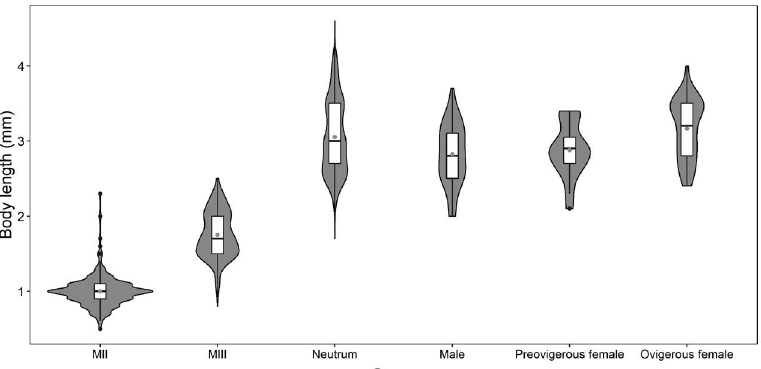
Fig. 3. – Violin plot combined with boxplot of length distributions within different developmental stages in Chondrochelia dubia . Grey dots are the mean values.